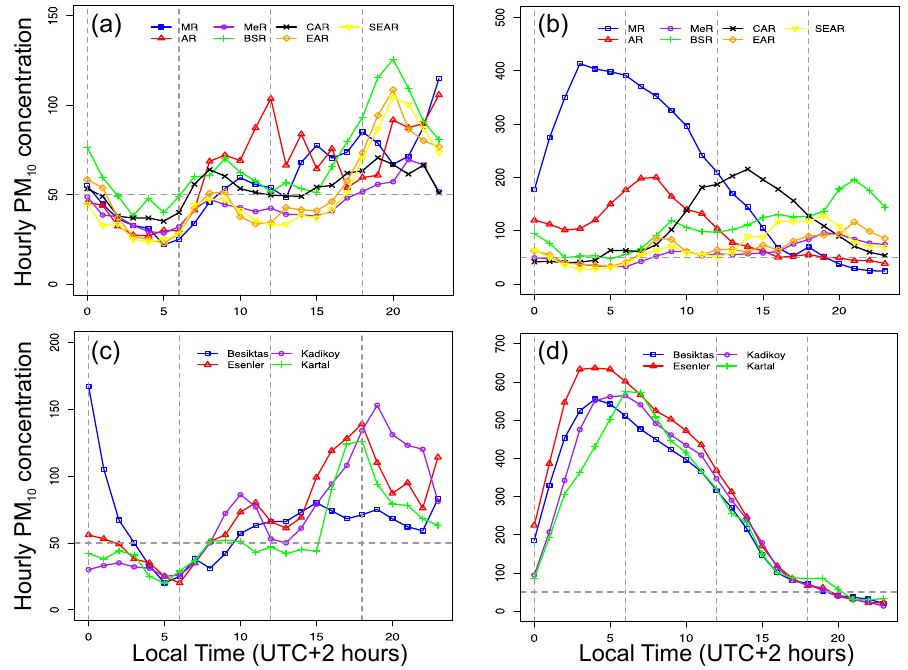
Figure 4. ( a ) Temporal behavior of the hourly PM 10 values ( μ g·m − 3 ) of the seven geographical regions of Turkey for 23 March, 2016. ( b ) same as ( a ) but for 24 March, 2016. ( c ) same as ( a ), and ( d ) same as ( b ) but denote the four urban settlements of Istanbul.